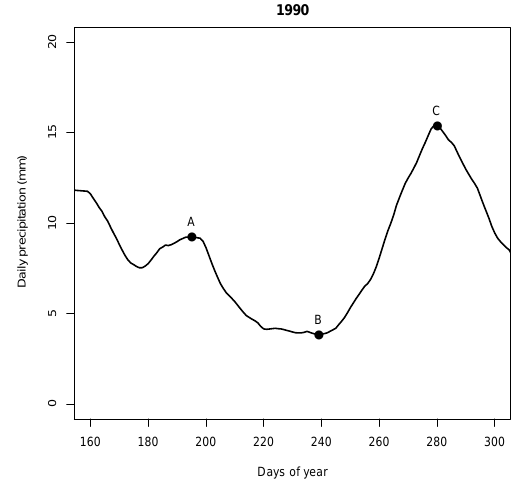
Figure 3. Filtered daily time series for the observed precipitation in station La Argentina during 1990. The dots represent the begin- ning (A), minimum (B) and end (C) of the MSD. In this year the MSD started by day 195 (14 July), reached the minimum at day 239 (27 August) and ended by day 280 (7